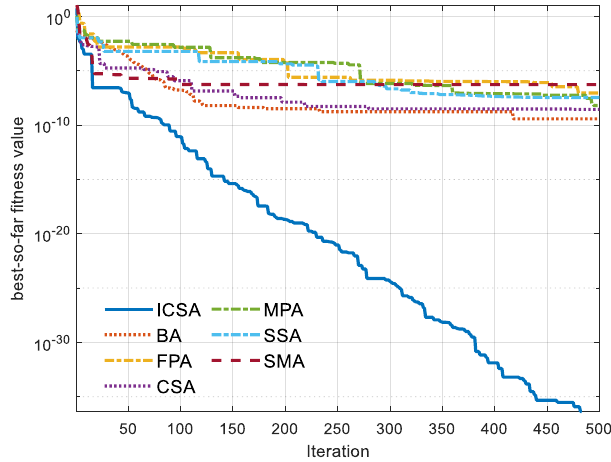
Figure 17. Convergence curve for F17.